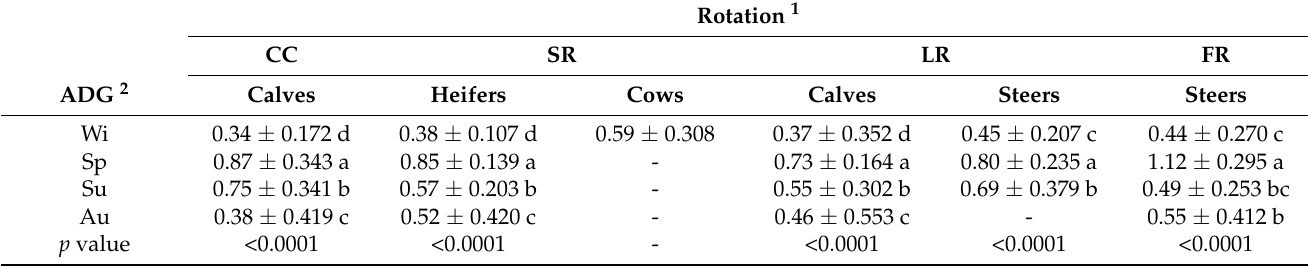
Table 9. Seasonal average daily gain (ADG, kg LW/d per animal) of cattle for the different